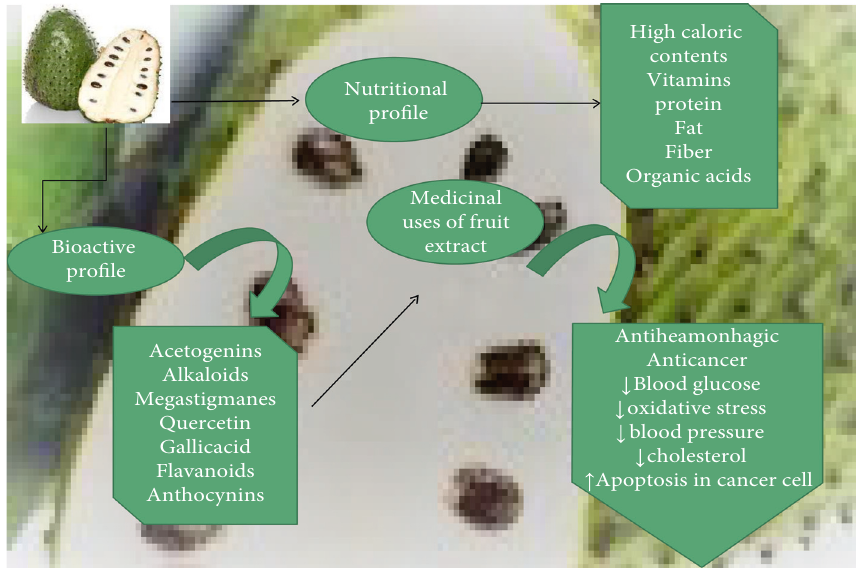
Figure 2: The nutritional and medicinal potential of